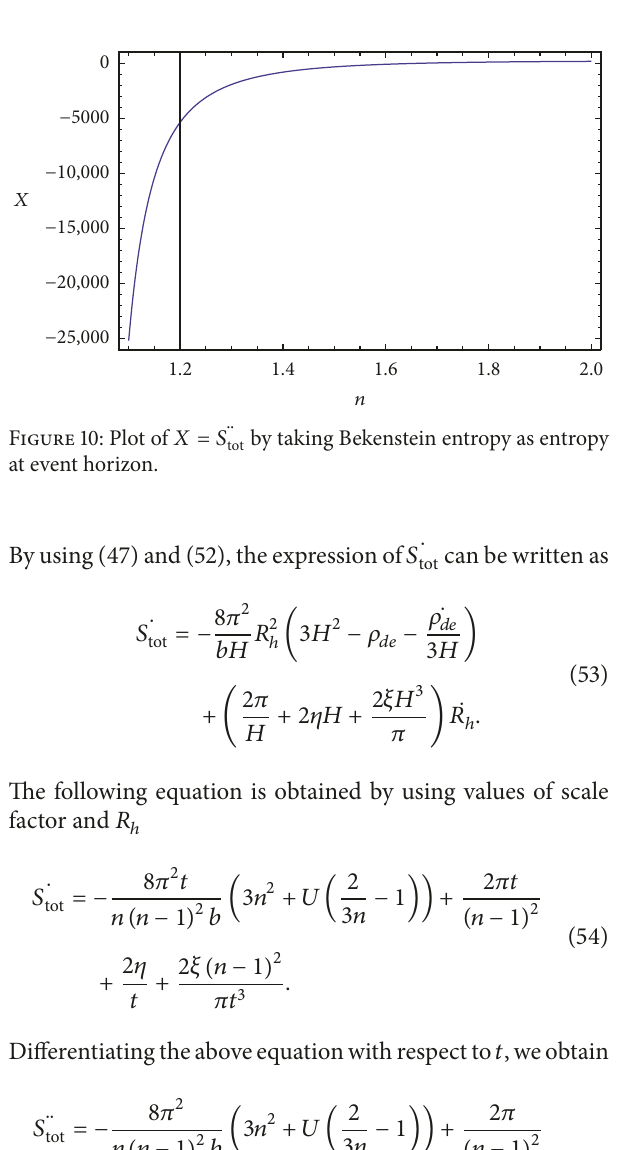
̇𝑆 Figure 9: Plot of tot by taking Bekenstein entropy as entropy at event horizon, where time is measured in seconds.